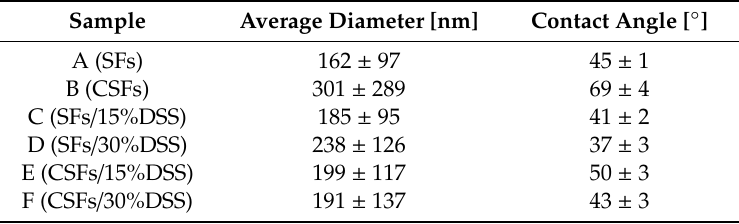
Table 2. The average diameter of individual electrospun fibrous mats A–F (see Figure 1) and their contact angles. All values are expressed as a mean ± SD.